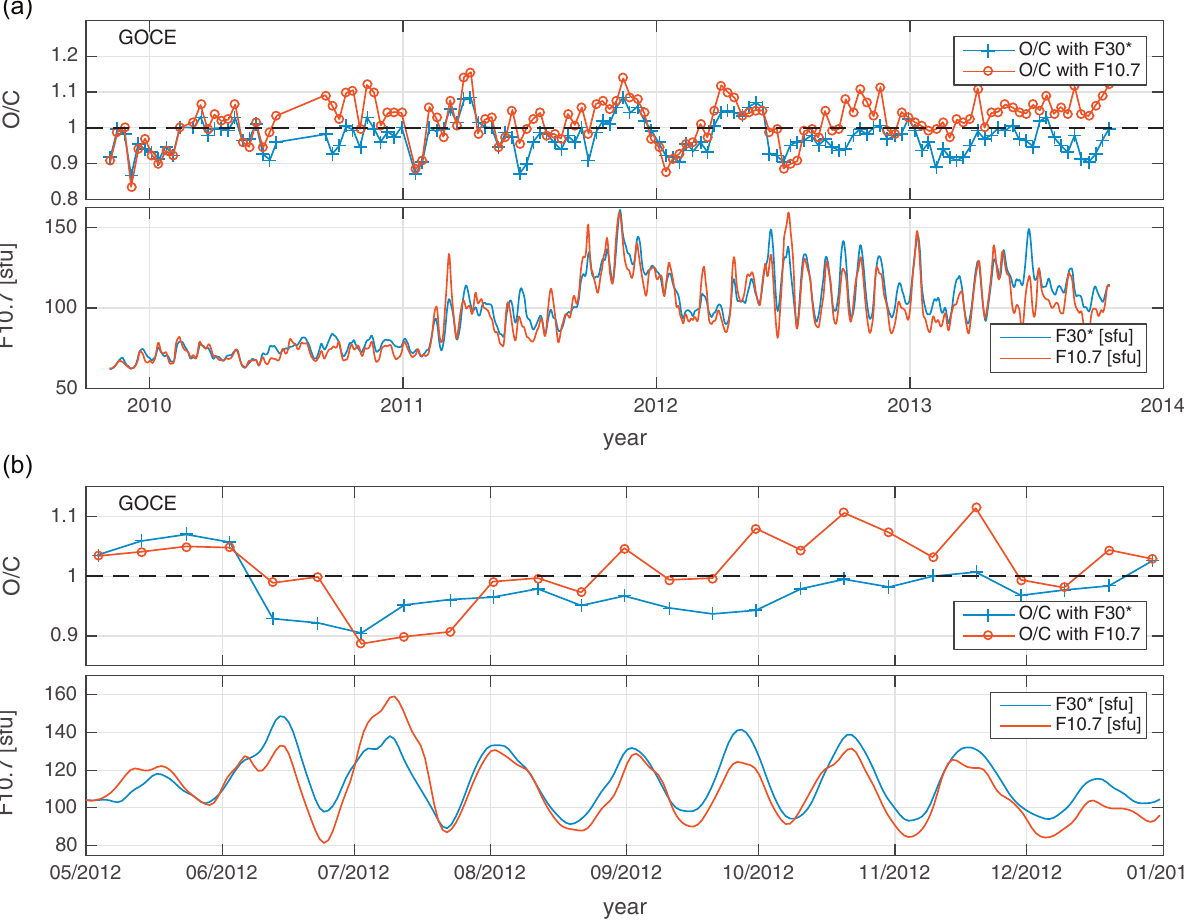
Fig. 7. 10-day averaged GOCE density ratios (O/C) obtained with the F10.7 and F30* thermosphere models and the daily F10.7 and F30* proxies. (a) Full record and (b) zoom on the period May–December